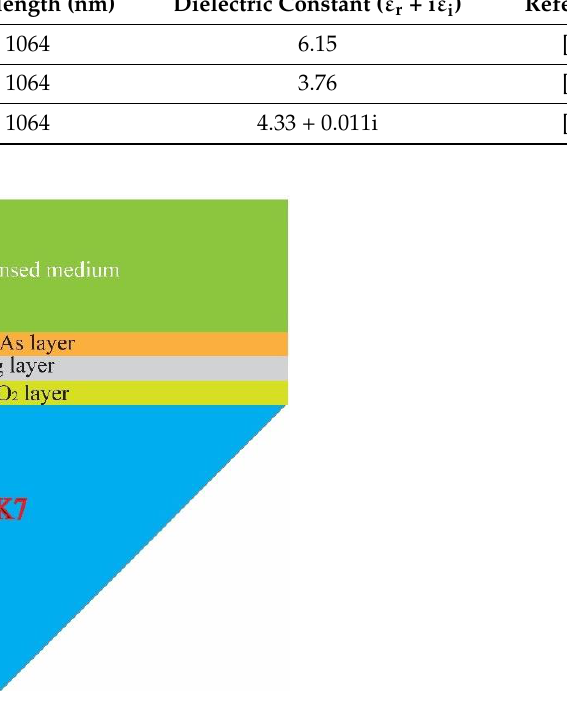
Figure 1. Sketch of the proposed sensor comprising the stacked layers of prism/TiO 2 /Ag/AlAs. For excitation of the surface plasmon wave, a collimated beam of IR laser with a wavelength of 1064 nm was incident to the prism surface by passing through a polarizer to obtain the transverse magnetic (TM) polarization light. To perform the simulation for the multilayer optical sensor, the simulated parameters are given in Table 1. Table 1. Parameters of materials used for simulation.